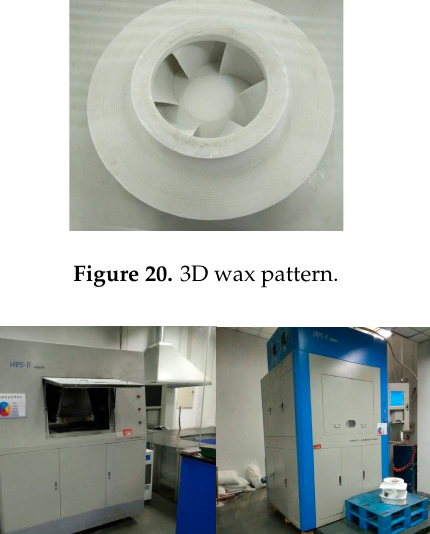
Figure 22. The casted impeller.